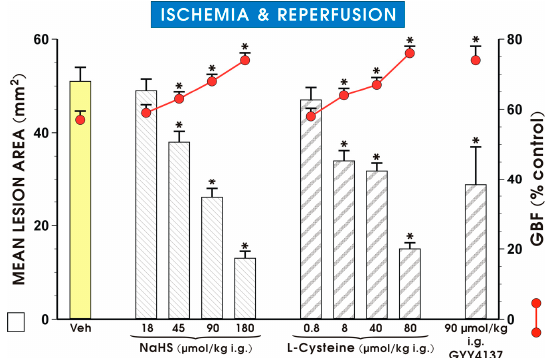
Figure 2. Mean lesion area and the GBF in gastric mucosa of rats pretreated with vehicle, NaHS (18–180 μ mol/kg i.g.), L -cysteine (0.8–80 μ mol/kg i.g.) or GYY4137 (90 μ mol/kg i.g.) and exposed to I followed by 3 h of R. Results are mean ± S.E.M of 4–5 rats per each experimental group. Significant changes as compared with the respective values in the vehicle-control group is indicated by an asterisk ( p < 0.05).